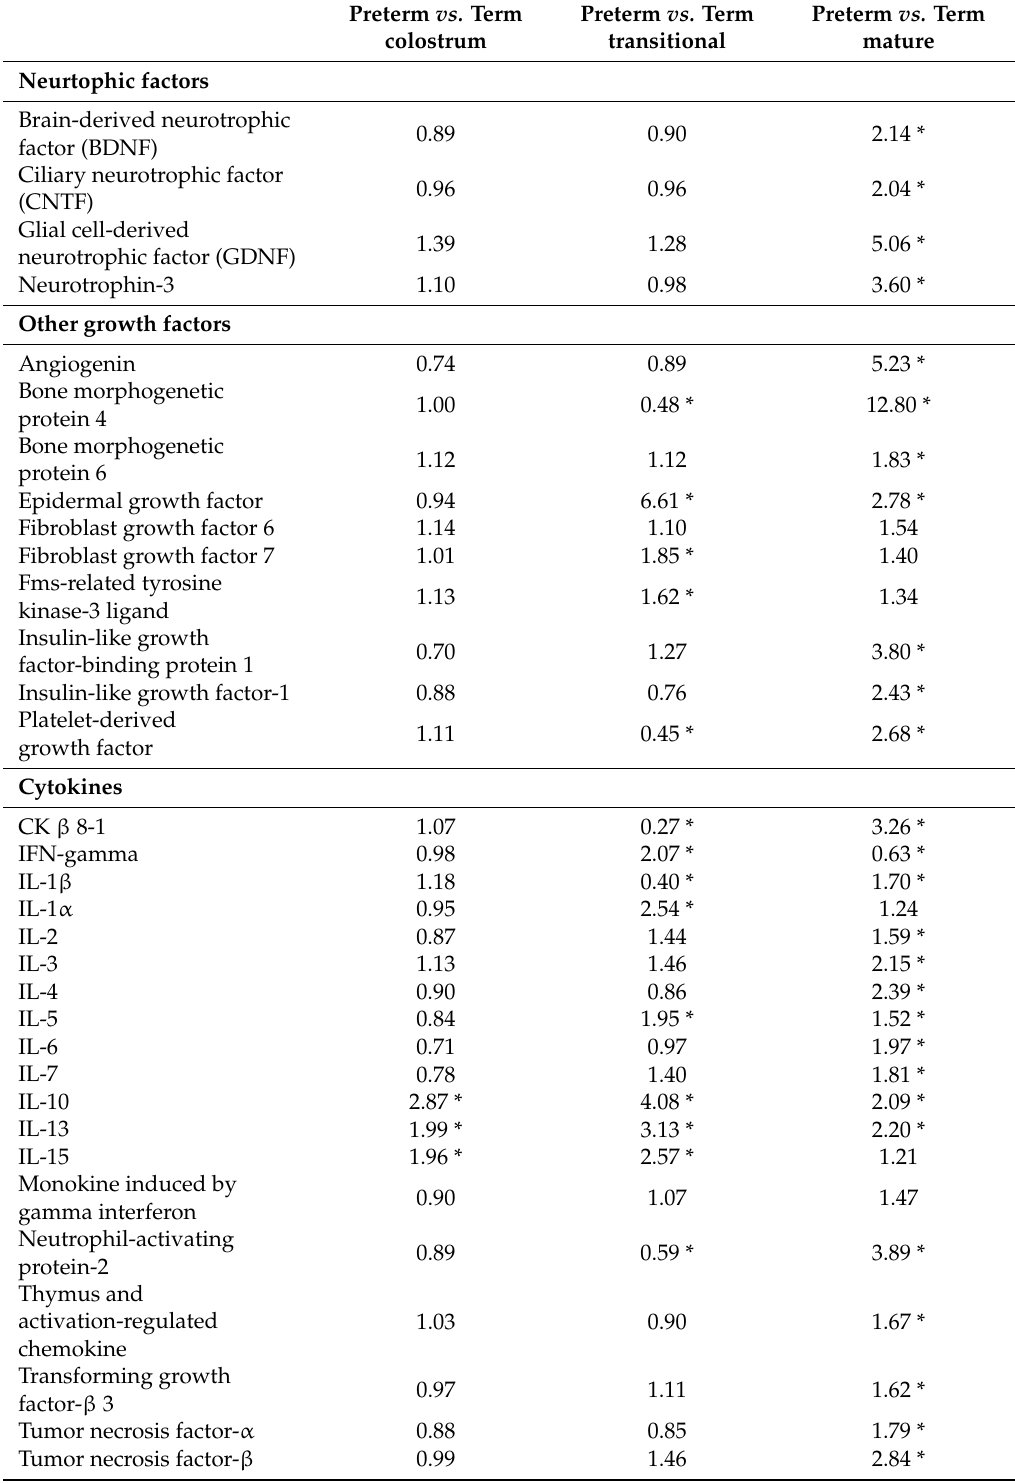
B: Fold change table comparing cytokine profile according to gestational